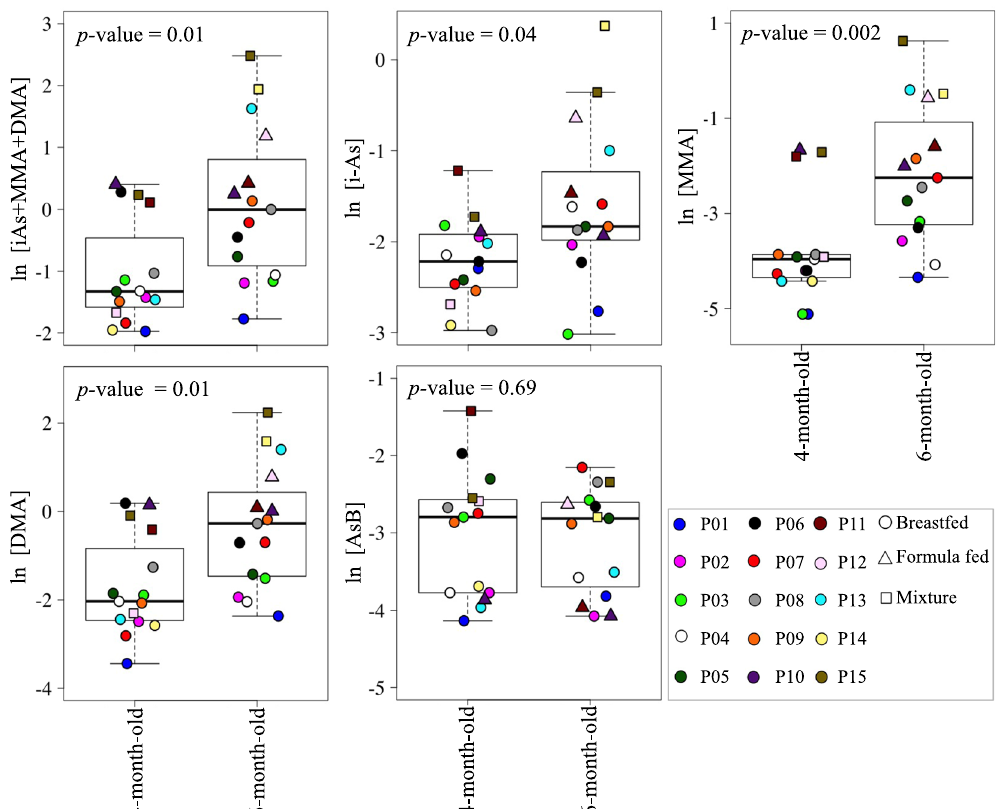
Figure 1. Concentrations of urinary arsenic species before (at 4 months of age) and during weaning (at 6 months of age) to solid foods. At 6 months of age infants’ diets included solid food in addition to breast milk, formula, or a mixture of both breast milk and formula. Each infant is identified by a unique color to facilitate the comparison between the two time points. The p -values were derived from paired Wilcoxon signed-rank test analyses. Urinary arsenic species concentrations were natural logarithm transformed to help